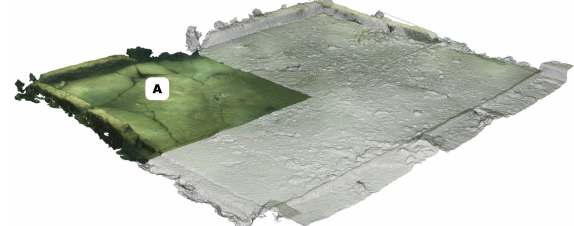
Figure 6. South-west Corner of The Cambell’s